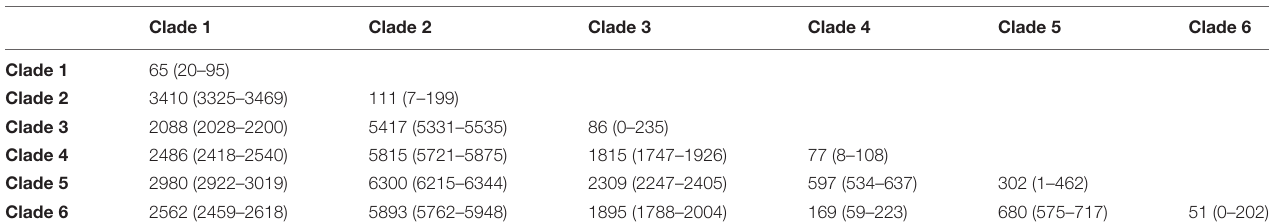
FIGURE 1 | E. coli ST182 phylogeny. (A) Mid-point root maximum-likelihood tree by core genome alignment showing genetic relatedness between 130 ST182 genomes. Isolates from this collection have tip label shaded in gray. Tree generated using IQTree2. (B) Mid-point rooted SNP-based phylogeny tree showing topology of the 46 airplane waste isolates only. Site 1: vacuum truck with waste from aircraft arriving from Mombasa, Canada, and Singapore. Site 2: Sewage from mixed aircraft tanks. Tree generated using Parsnp. Both trees visualised using iTOL. TABLE 1 | Average SNP distances across E. coli ST182 clades (Range in